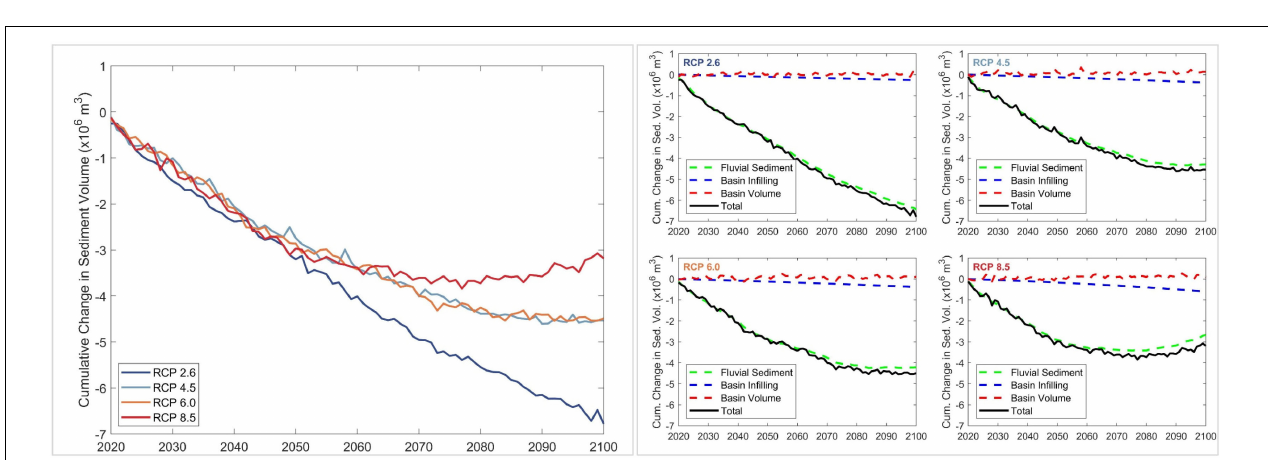
FIGURE 8 | Projected change in total sediment volume exchange ( (cid:49) V T ) between the Dyfi estuary and the adjacent coast (left) , and the relative contributions of the three different sediment volume components (right) over the 21 st century for RCP 2.6, 4.5, 6.0, and 8.5. Negative and positive values of (cid:49) V T indicate sediment imported to the estuary from the adjacent coast and sediment exported from the estuary to the adjacent coast, respectively.